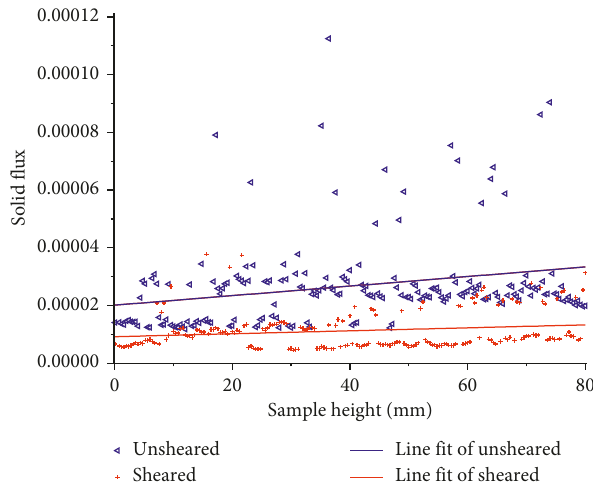
Figure 12: Solid fluxes of sheared and unsheared